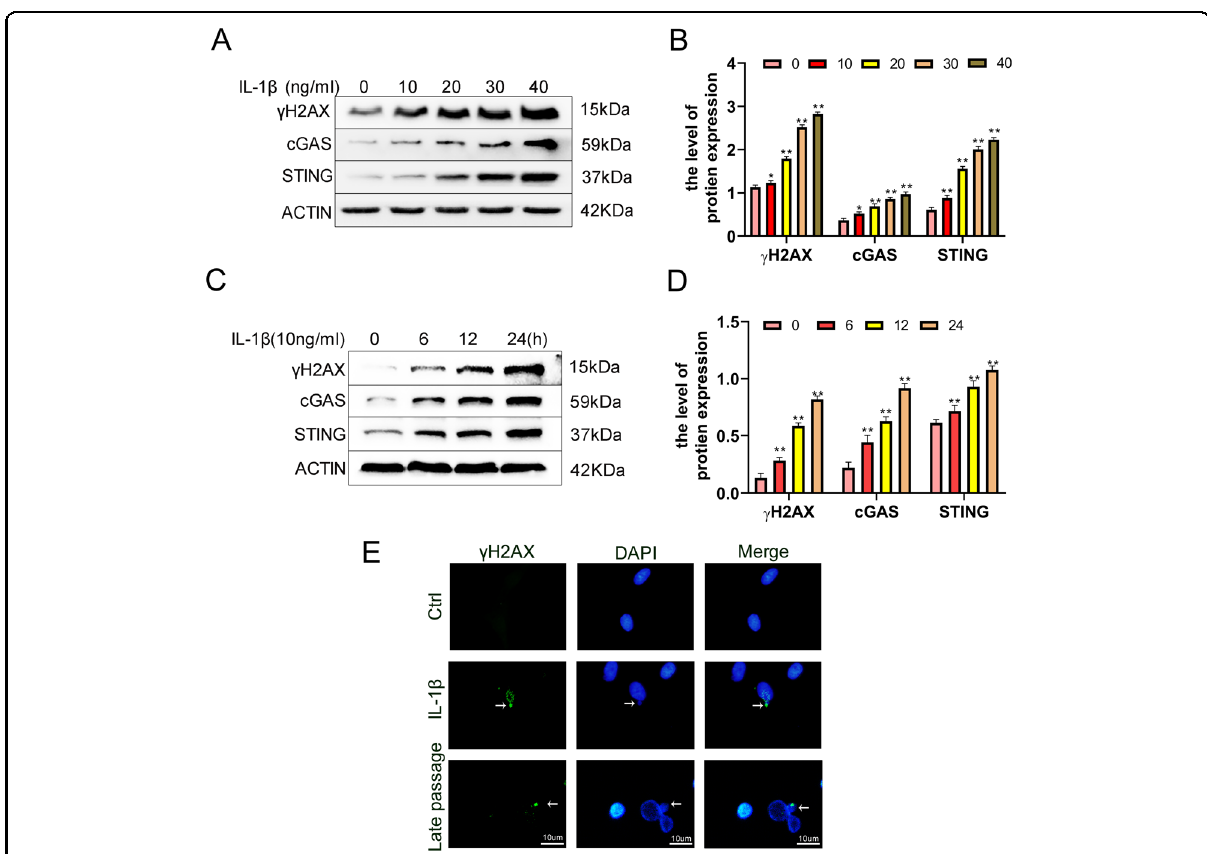
Fig. 2 The expression of STING is increased in IL-1 β -triggered chondrocytes. The protein expression of γ h2ax, cGAS, STING in chondrocytes were explored by western blot and its quanti fi cation was detected by ImageJ. A – B The impact of different concentrations of treatment with IL-1 β on mouse chondrocytes. The chondrocytes were exposed to 0, 10, 20, 30, 40 (ng/ml) IL-1 β for 24 h. C – D The impact of different durations of treatment with IL-1 β on mouse chondrocytes. The chondrocytes were incubated with IL-1 β (10 ng/ml) for 0, 6, 12, 24 h. E Representative immuno fl uorescence staining of γ h2ax in IL-1 β (10 ng/ml, 24 h) induced chondrocytes (bar:10 μ m). All data were indicated as the mean ± SD ( n = 5); * P < 0.05, ** P <